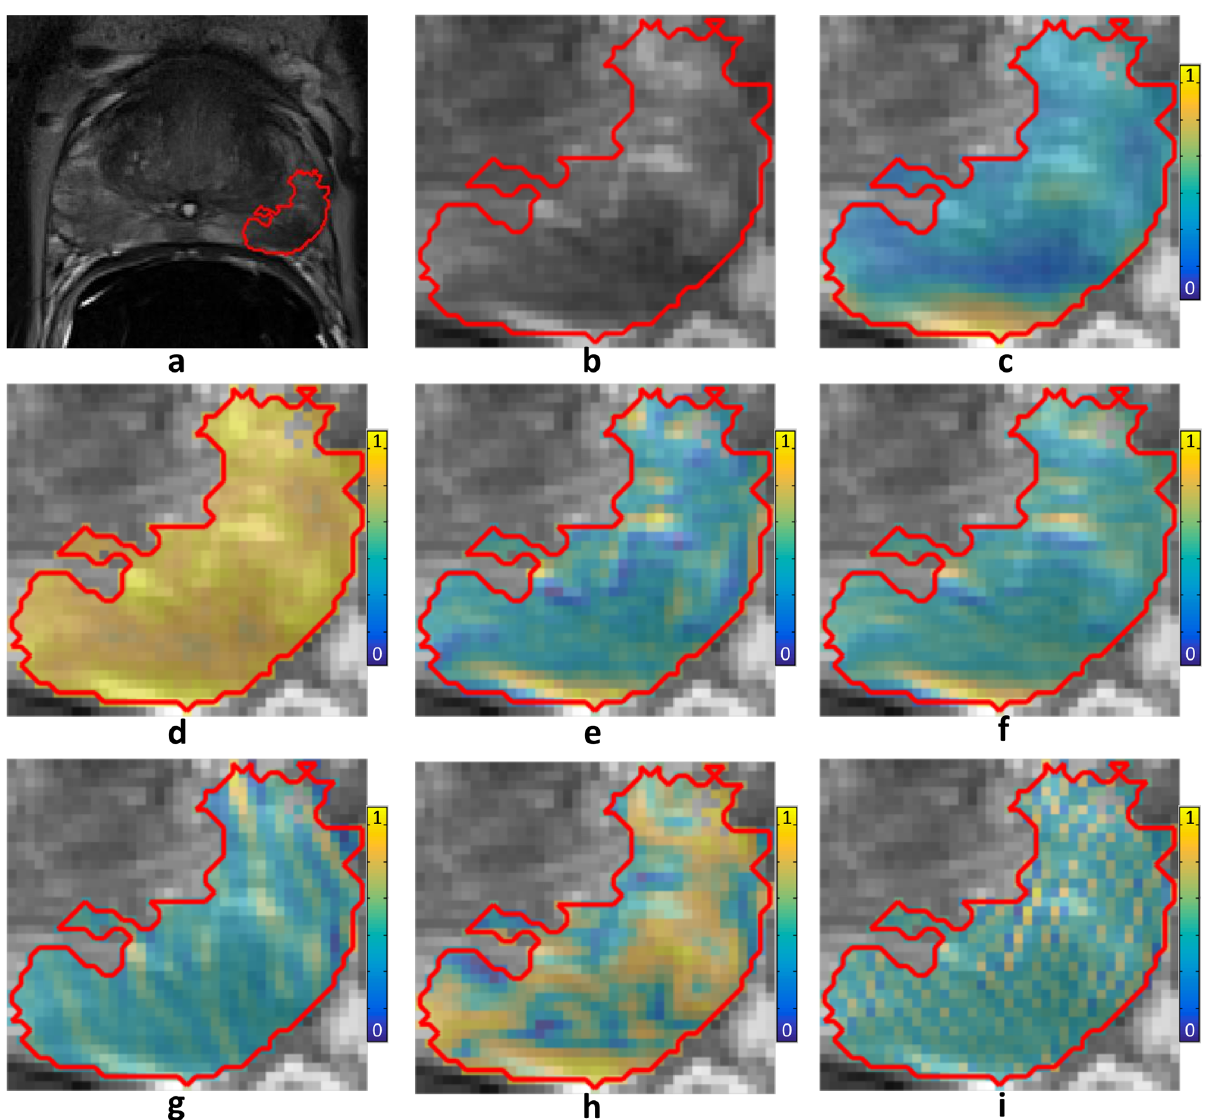
was identified by performing minimum redundancy maximum relevance (mRMR) feature selection [65] on D . To reduce the likelihood of over-fitting the predictive model to the train- 1 ing data, the top seven (roughly one tenth of the number of samples) most frequently selected features from one thousand repetitions of three-fold cross-validation (CV) were identified based on voting across all repetitions of CV. In each repetition of CV, classification perfor- mance of the selected features was quantified to obtain an initial estimate of the predictive potential using a random forest (RF) classifier, which has been shown to be most prognostic and stable classifiers for radiomic features.